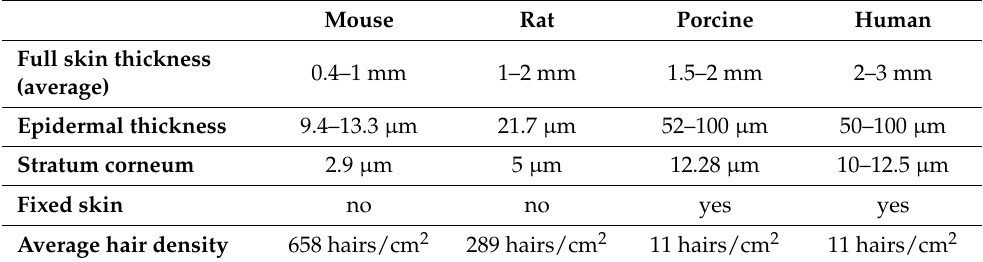
Table 5. Comparison of the dermal barrier properties of four different species (modified from Liu et al., 2009 [49]).